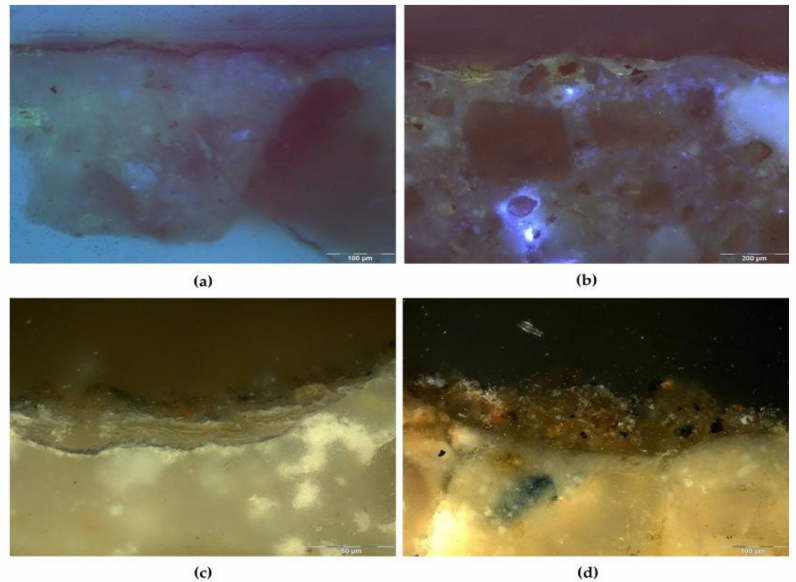
Figure 9. Micrograph of the painting layer: ( a ) sample MY44 and ( b ) sample MY33 in UV light; ( c ) sample MY33; ( d ) sample MY45e in visible